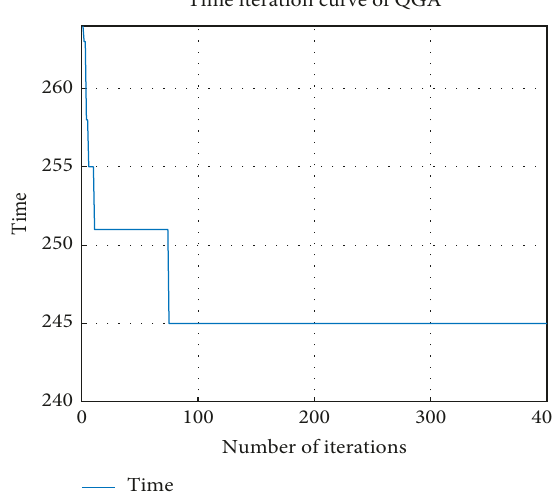
Figure 6: Iteration curve of cost in the multiobjective quantum genetic